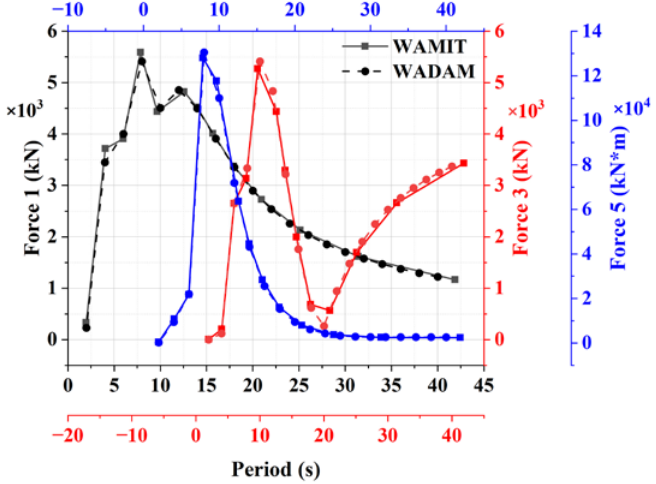
Figure 6. Comparison of the first-order wave excitation loads from WADAM and WAMIT.